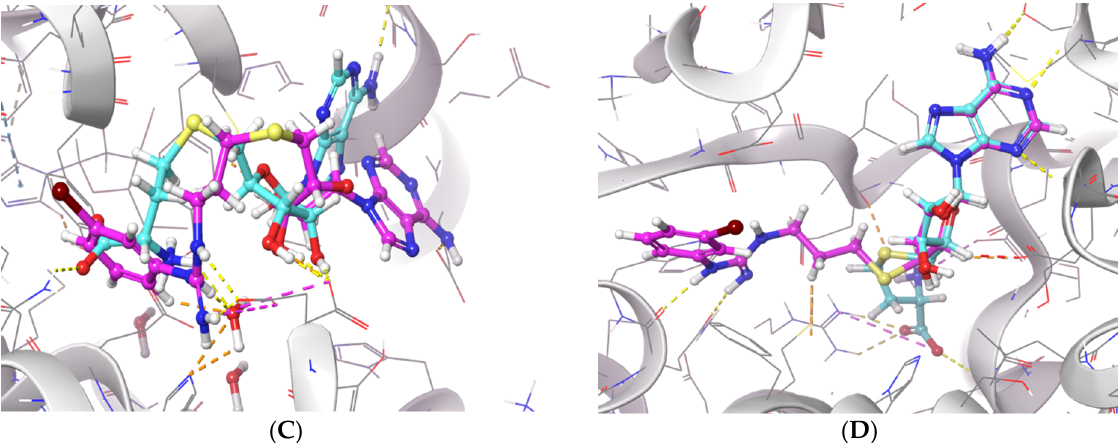
Figure 7. The in silico interaction of II757 inside the pocket of ( A ) PRMT1 (PDB: 6nt2), ( B ) PRMT4 (PDB: 6s79), ( C ) PRMT5 (PDB: 6ckc), and ( D ) PRMT7 (PDB: 4m37). II757 is shown in the magenta stick and ball model.